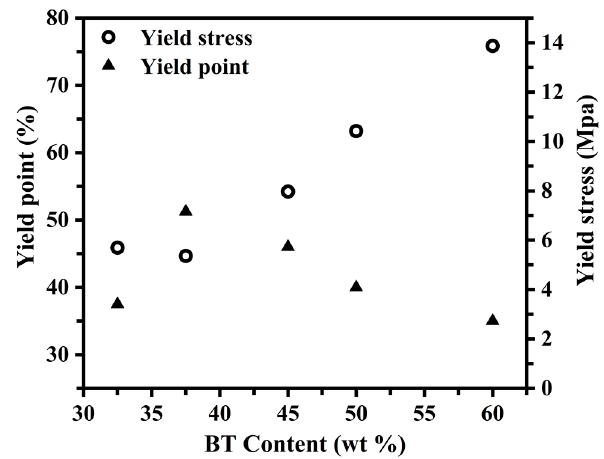
Figure 6. The yield point and yield stress of PBST copolymers with different BT